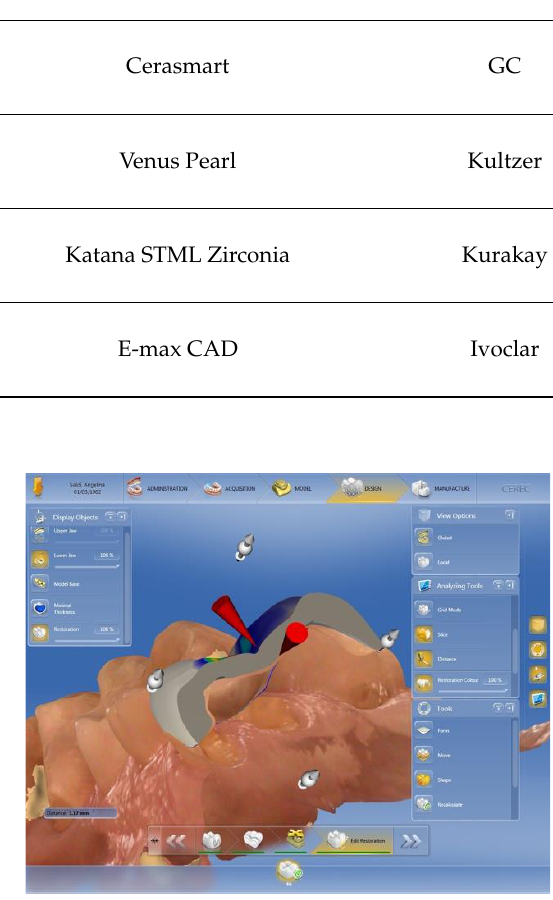
Figure 2. CAD design of tabletop restorations, controlling standardized anatomy and thickness.